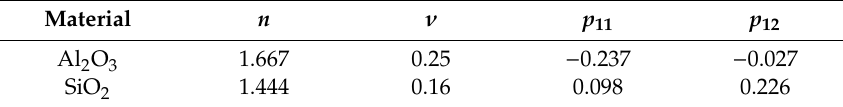
Table 4. Bulk parameters of alumina and